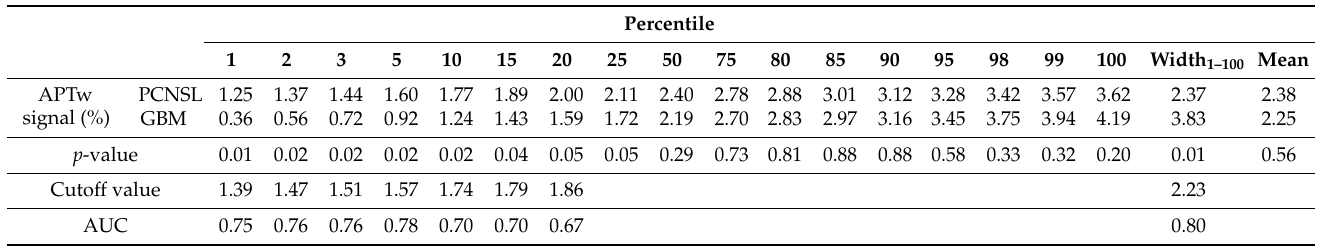
Table 2. The mean, percentile, and width 1–100 APTw signal values of PCNSL and glioblastoma,